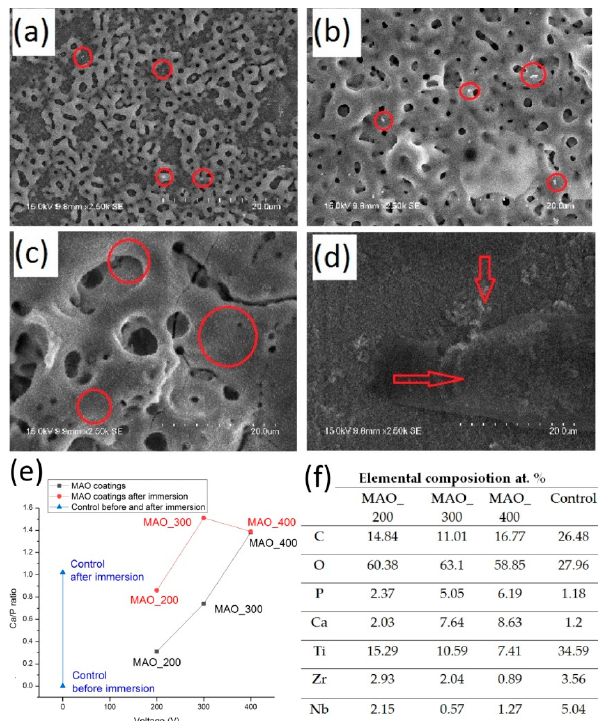
Figure 6. Surface morphologies of the samples after soaking in Hank’s solutions for 72 h: The control group ( d ) and the MAO coatings obtained at various applied voltages in a constant current of 32 mA and time processing equal to 15 min ( a – c ): MAO_32_15_200 ( a ), MAO_32_15_300 ( b ), and MAO_32_15_400 ( c ). The Ca / P ratio ( e ) and elemental composition ( f ) of the post-immersed specimens (the presented results are representative for three analyses of each surface treatment specimens).